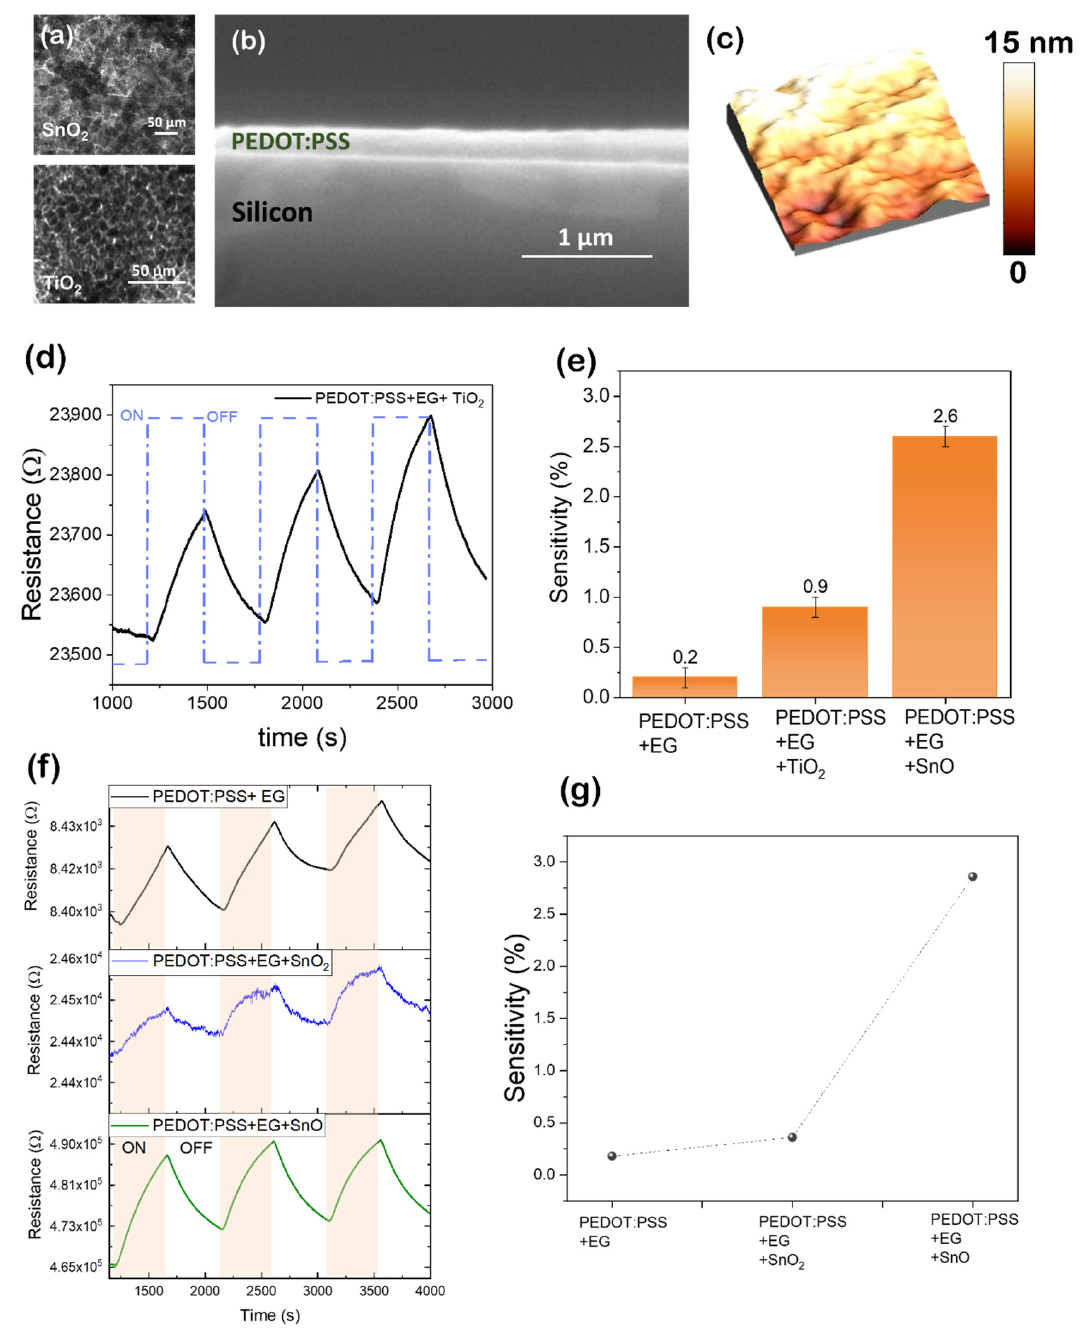
Figure 15. ( a ) TEM images from SnO 2 and TiO 2 nanoparticles. ( b ) Cross-sectional SEM image of a PEDOT:PSS layer spin coated onto a Si substrate. ( c ) AFM image of a PEDOT:PSS layer ( d ) resistance response at RT of the PEDOT:PSS/TiO 2 composite due to ethanol exposure. ( e ) Sensitivity of the composites compared with PEDOT:PSS/SnO. Adapted with permission from [57]. Copyright by SPIE (2022). ( f ) Resistance of the hybrid layers under ethanol exposure and ( g ) calculated sensitivity for the first cycle of each sample. Adapted with permission from [58]. Copyright by Wiley-VCH (2022).